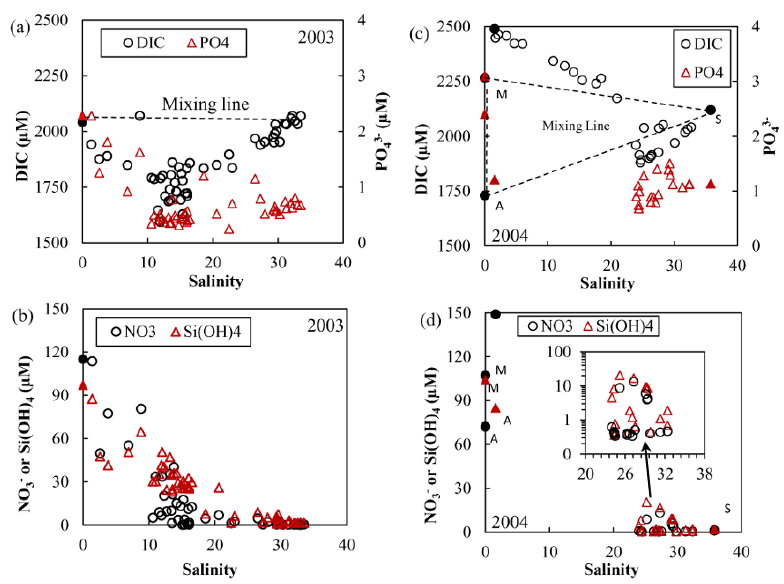
Fig. 3. Variation of DIC and nutrient concentrations along the salinity gradient. DIC versus salinity, and PO 3 − versus salinity and Si(OH) 4 versus salinity (b) for June 2003. DIC versus salinity and PO 3 − Si(OH) 4 versus salinity (d) for August 2004. End-members (solid circles) with abbreviations, “M”, “A”, and “S” in (c) and (d) are as those in Fig. 2f. Conservative mixing lines (dashed lines) are shown for DIC versus salinity in (a) and (c) . The inserted figure on (d) enlarges the crowded area with logarithm scale in y-axis. Nutrient data for waters with salinity less than 24 were unavailable in August